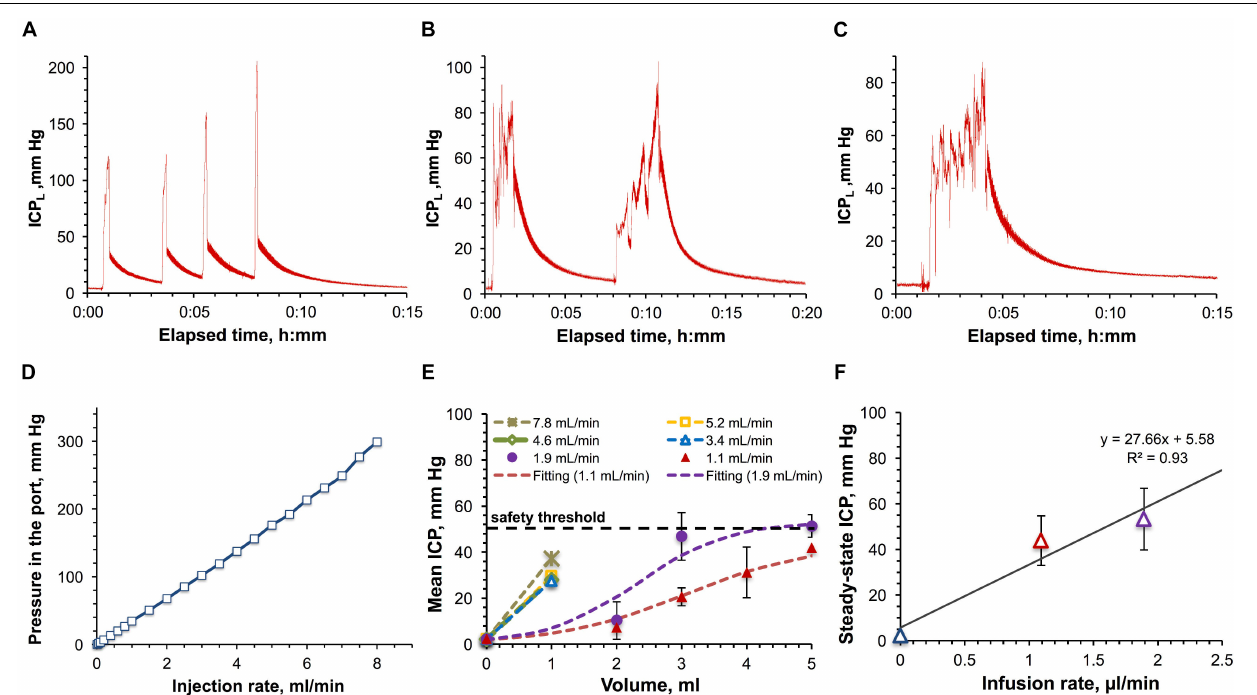
FIGURE 5 | Large-volume bolus IT injections in monkeys. (A) Time-dependence of the ICP measured in-line (ICP L ) for a series of 1 ml bolus injections in the cynomolgus monkey with the average infusion rate of 5.3 ± 1.8 ml/min. (B) Time-dependence of ICP L for a series of 3 ml infusions in the cynomolgus monkey with the average infusion rate of 1.9 ± 0.6 ml/min. (C) Time-dependence of ICP L for a 5 ml bolus injection in the rhesus monkey with the infusion rate of 1.8 ml/min. (D) Relation of the pressure in the IT injection port with the injection rate. (E) Dependence of the CSF pressure (ICP) on the infused volume for different infusion rates in the rhesus and cynomolgus monkey. The ICP was derived by correcting the ICP L for the resistance pressure in the port. (F) Relation of the approximated steady-state ICPs with the infusion rates. Parameters of the linear regression are shown. Error bars on the panels (E,F) represent standard